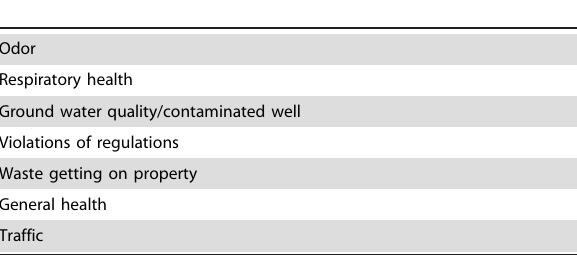
Table 1. Topics of concern ranked in descending